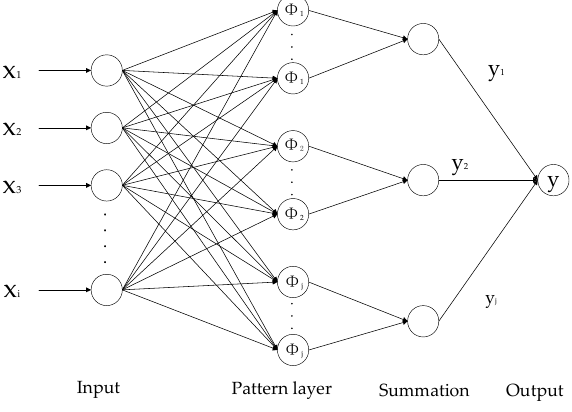
Figure 6. The distinction between normal condition and recessive weakness.